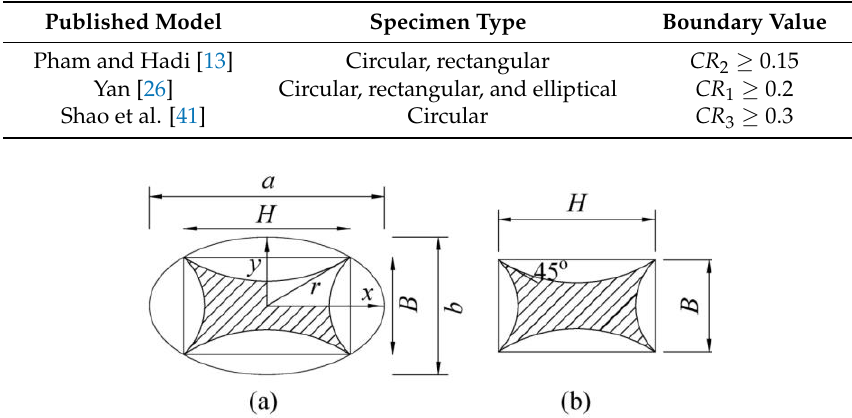
Figure 3. Effective confined concrete area in elliptical-sectioned column: ( a ) an elliptical jacketing scheme for an excising rectangular-sectioned column; ( b ) a rectangular concrete block with the same aspect ratio is considered, internal to the elliptical concrete section. Table 2. Published models of boundary value for sufficiently confined concrete.